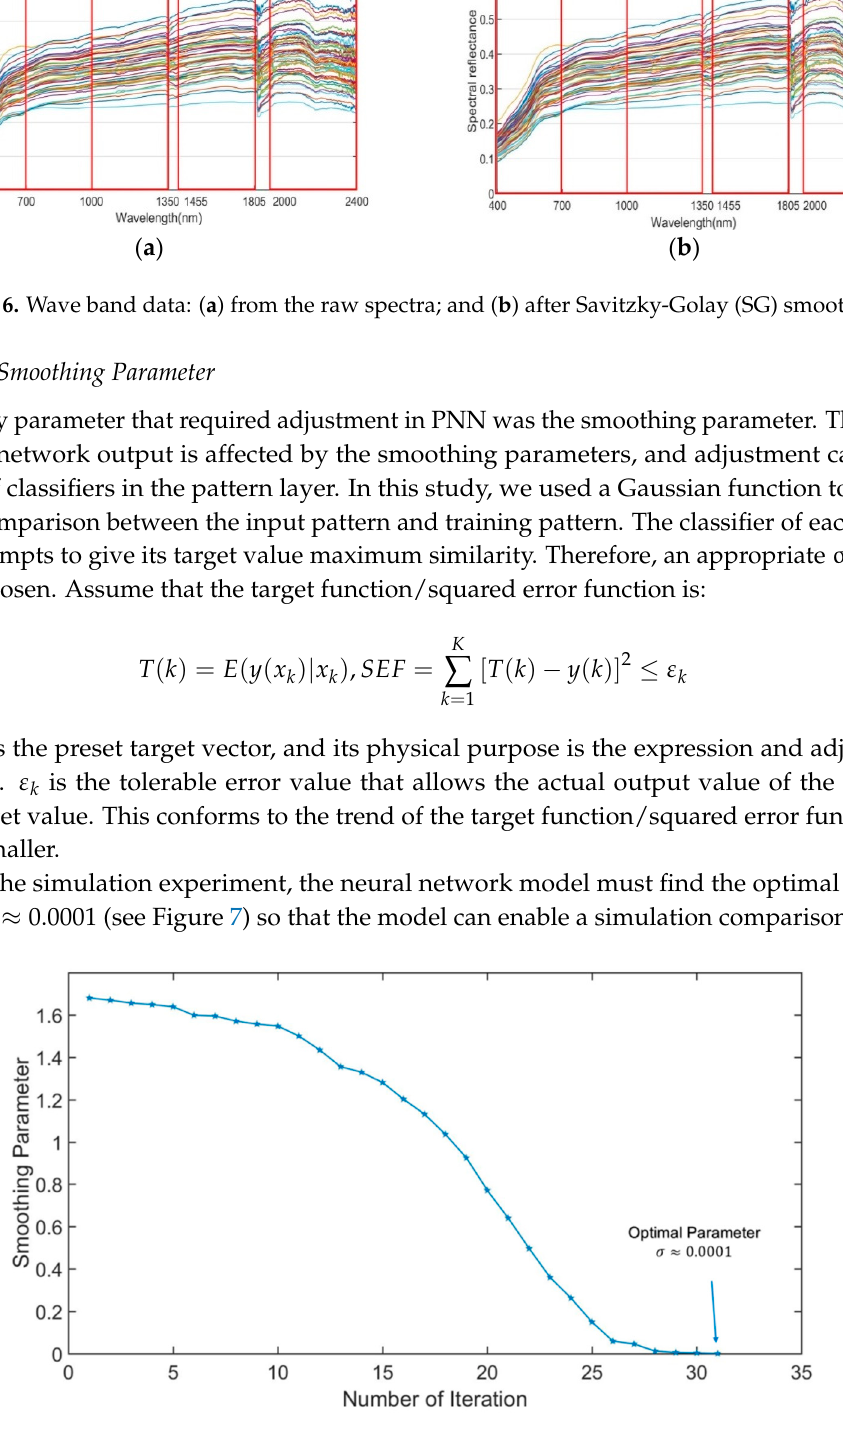
Figure 7. Optimal smoothing parameter.